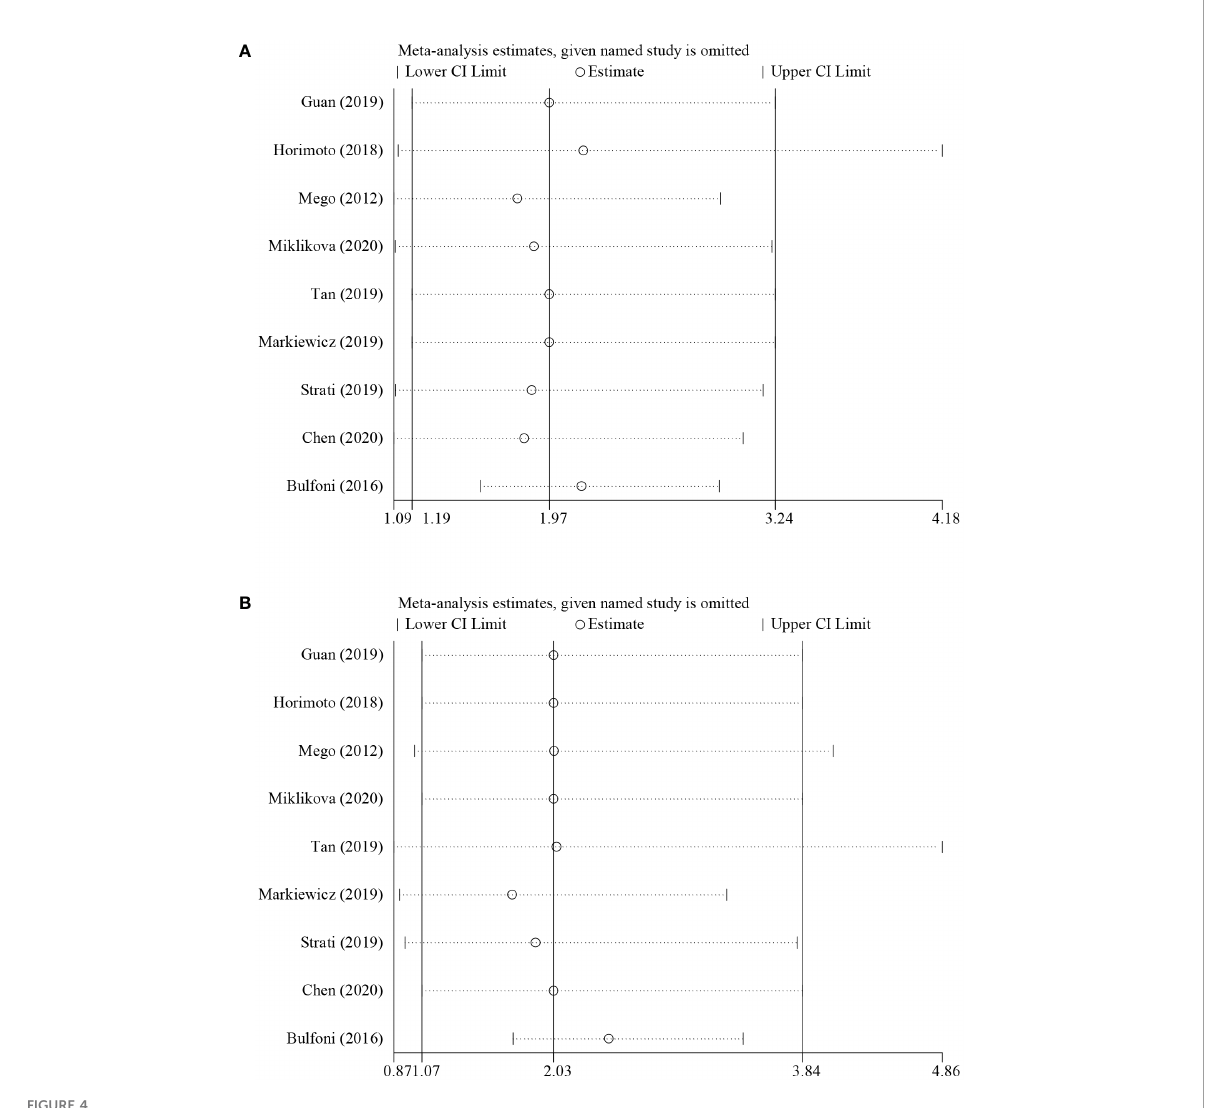
FIGURE 4 Sensitivity analysis of the pooled HRs for (A) PFS and (B)